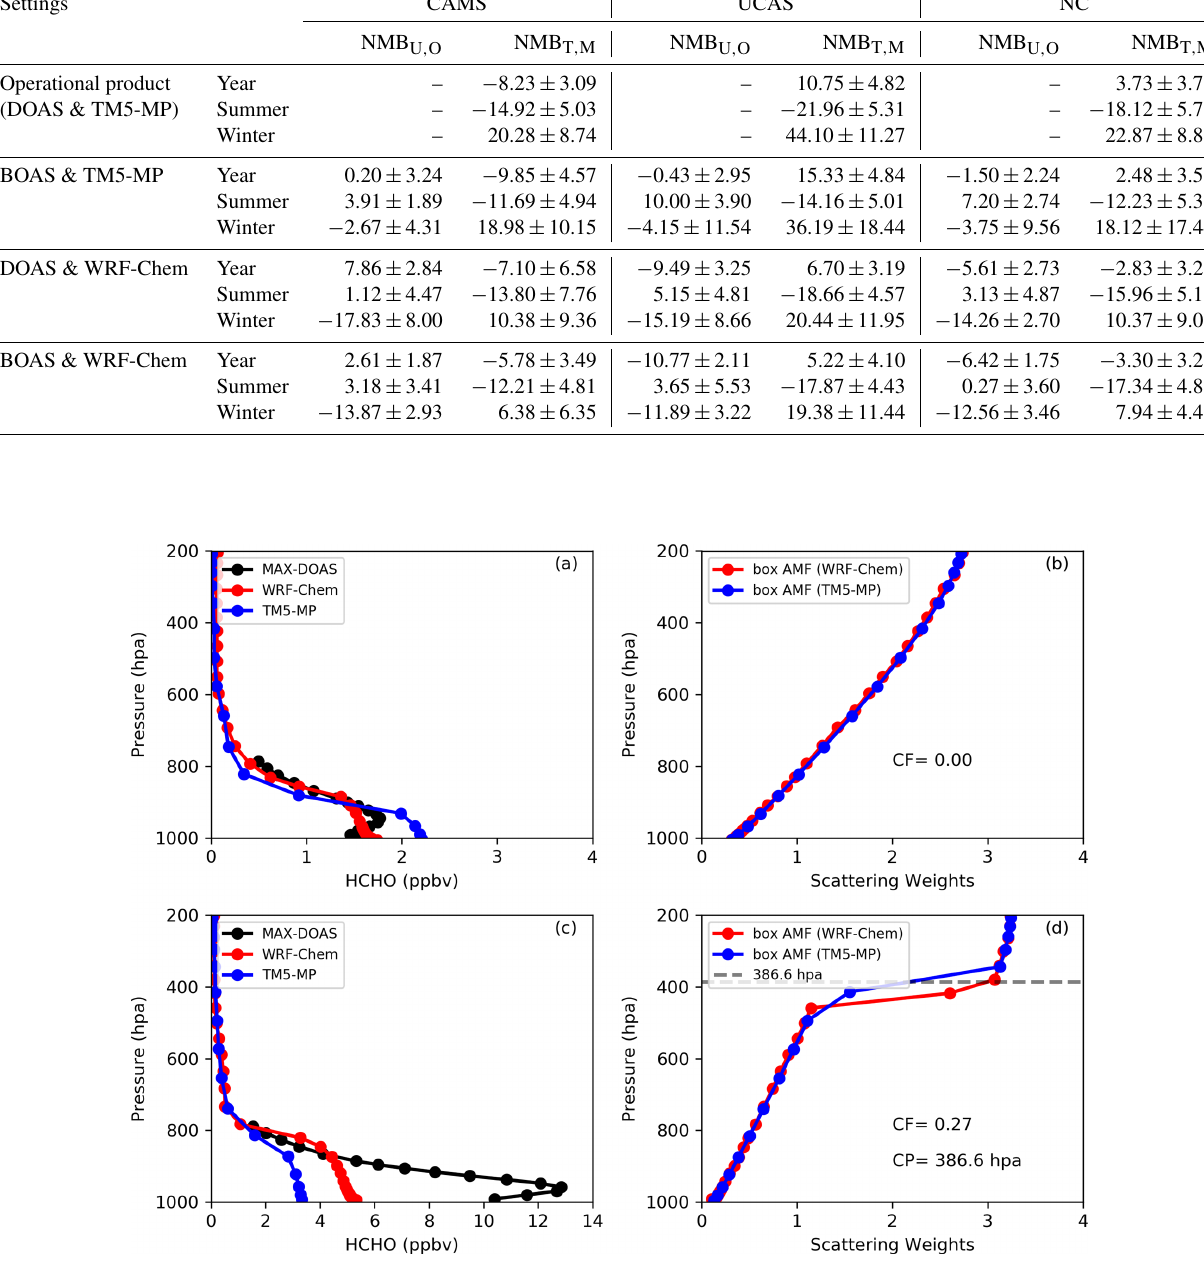
Figure 6. Daily averaged vertical HCHO profiles obtained from MAX-DOAS, WRF-Chem and TM5-MP model in the clean case on 3 March 2019 (a) and in the polluted case on 26 June 2019. Comparisons of the box AMF using WRF-Chem and TM5-MP simulations in the clean case with clear sky on 3 March 2019 (b) and in the polluted case with cloudy sky on 26 June 2019 (c) . The locations of the two pixels are within 20km of the CAMS